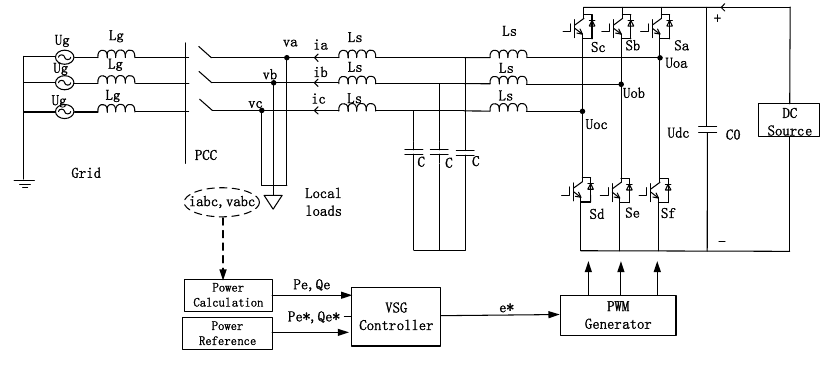
Figure 3. Topology of VSG.